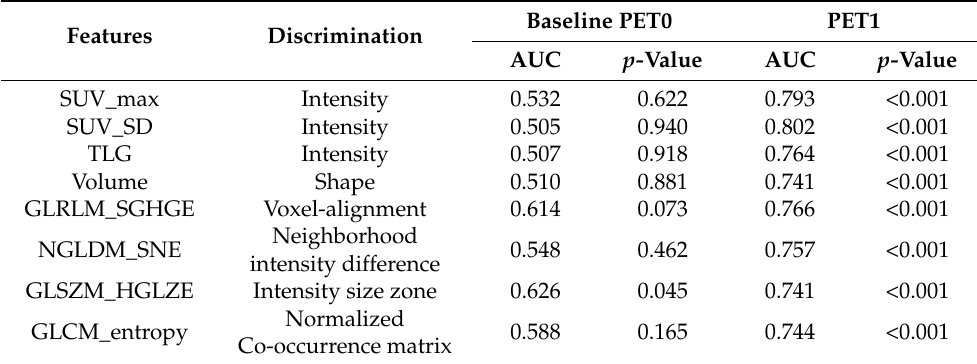
Figure 3. T-SNE plot using image texture features of osteosarcoma patients. In the plot, 0 represents the chemotherapy non-responder and 1 represents the chemotherapy responder. Table 4. The area under the receiver operating characteristic curve for 18 F-FDG uptake hetero- geneity